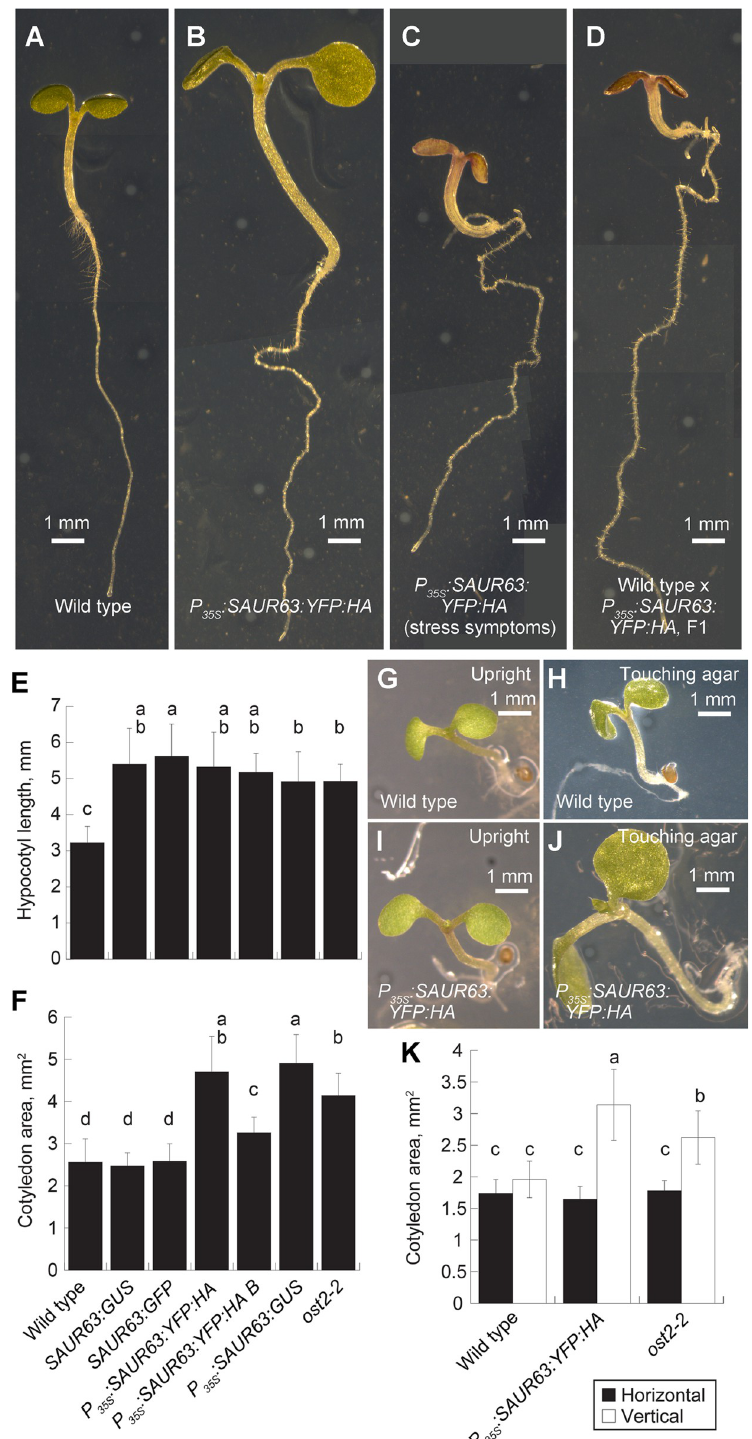
Fig 1. Hypocotyl and cotyledon phenotypes of plants expressing SAUR63:X fusion proteins. A-D) Photographs of 5-day-old seedlings of indicated genotypes. Seedlings were grown in long days in presence of sucrose to allow root growth of all genotypes. For the F1 seedling shown in D, wild type was the female parent. Scale bars, 1 mm. E) Hypocotyl lengths of seedlings of indicated genotypes grown for 4d in short days on 0.5x MS medium. F) Cotyledon areas of seedlings of indicated genotypes grown for 6d in long days on 1x MS 1% sucrose medium.